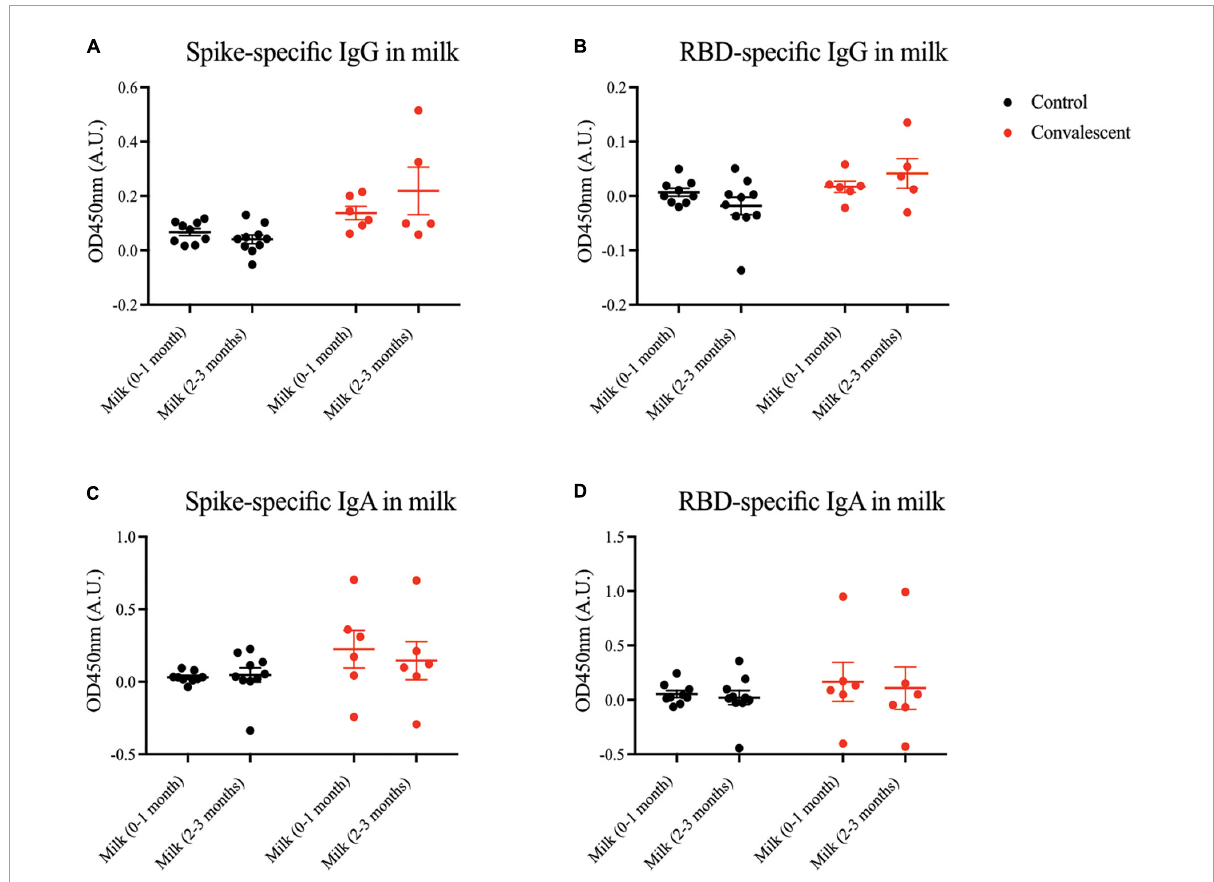
FIGURE7 Increased secretion and production of spike-specific IgA and IgG antibodies post-vaccination in convalescent mothers. Breast milk from three nursing convalescent mothers were collected at 4 time points, prior to vaccination (0), 3 days post-vaccination, 7 days post-vaccination, and 30 days post-vaccination for a (A,C) spike and (B,D) RBD protein-based IgA and IgG ELISA assay. The x -axis refers to the number of days